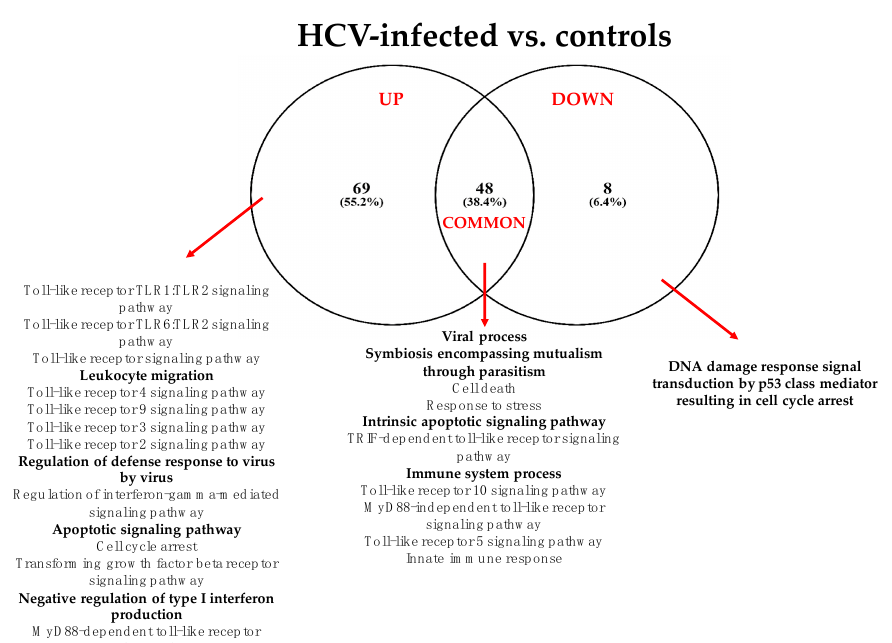
Figure 1. Summary of the “Gene Ontology-Biological Process” enriched functional terms associated with the predicted target genes of miRNAs differentially expressed in LB obtained from HCV-infected patients vs. healthy livers. Some of the most relevant biological processes are shown; the complete lists of enriched terms are available in Supplementary Table S6A.